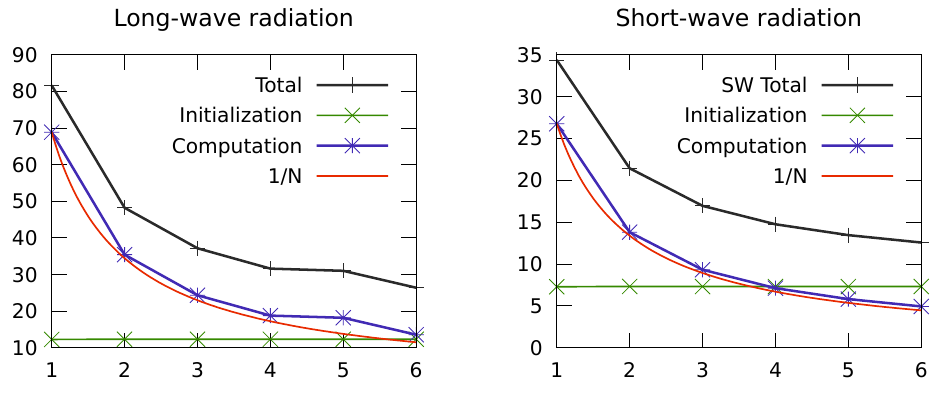
Fig. 5. The computation time of the long-wave and short-wave radiation as a function of the number of SPEs used.